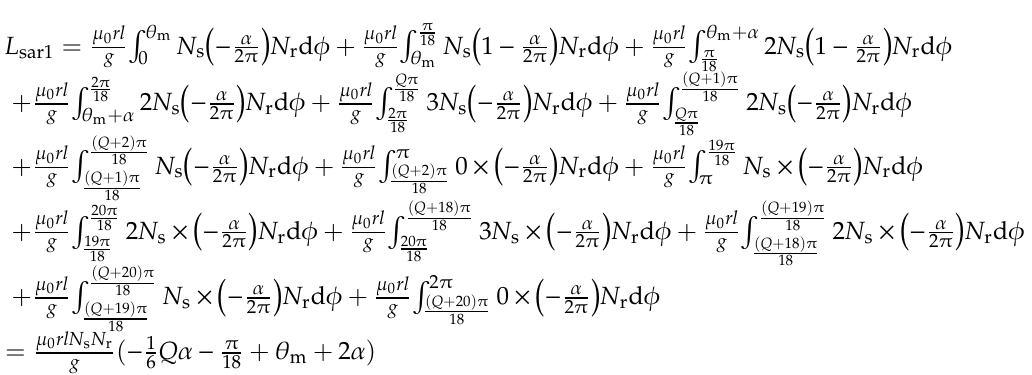
Figure 8. Mutual inductance between the stator and the rotor loop. Figure 9. The derivation to the rotor position. Table 1. Mutual inductance and its derivation with respect to rotor position. Rotor Position